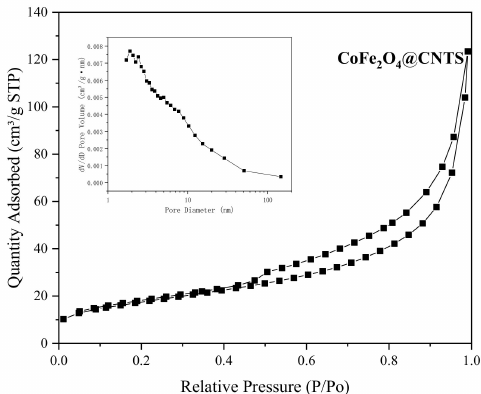
Figure 5. Nitrogen adsorption–desorption isotherm and pore size distribution of CoFe 2 O 4 @CNTs (insert).